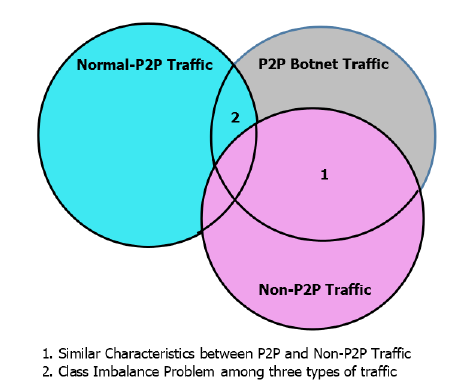
Figure 2. Overlapping qualities among three types of